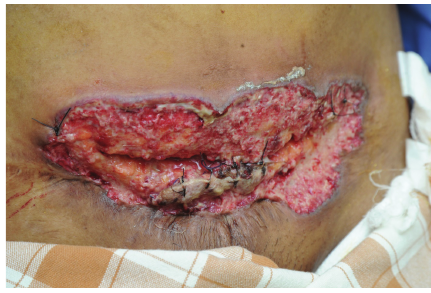
Figure 1: Appearance of caesarean wound on 9th post-op